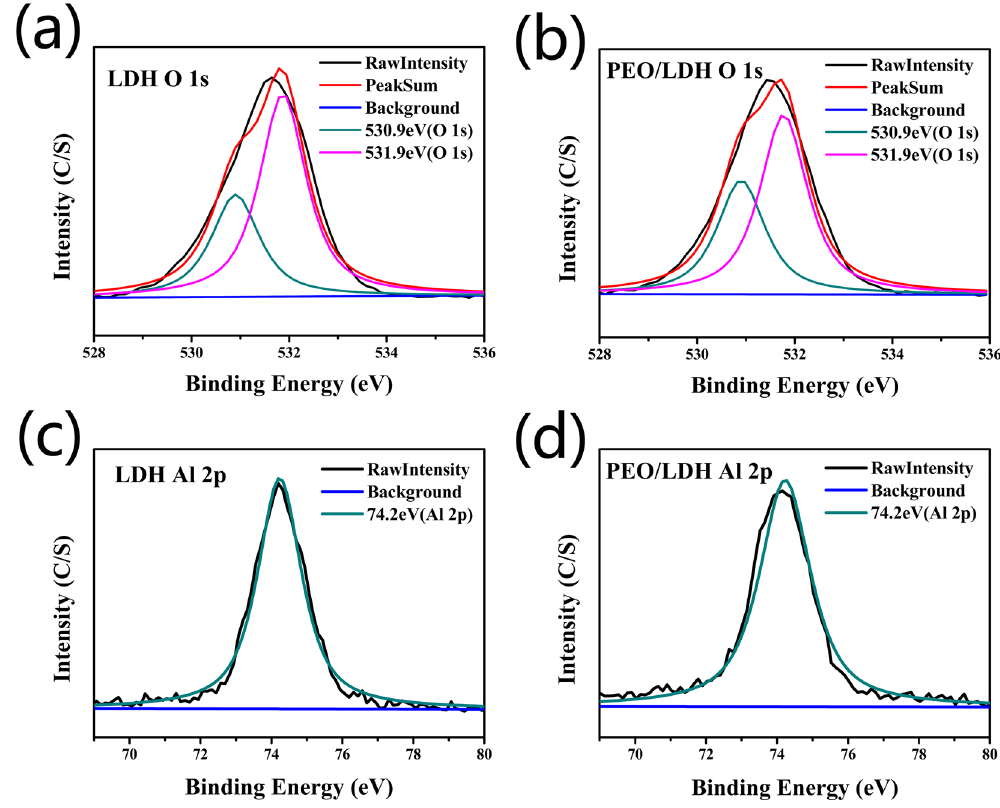
Figure 4. High-resolution spectra of O 1 s of LDH ( a ) and PEO/LDH ( c ), Al 2p of LDH ( b ) and PEO/LDH ( d